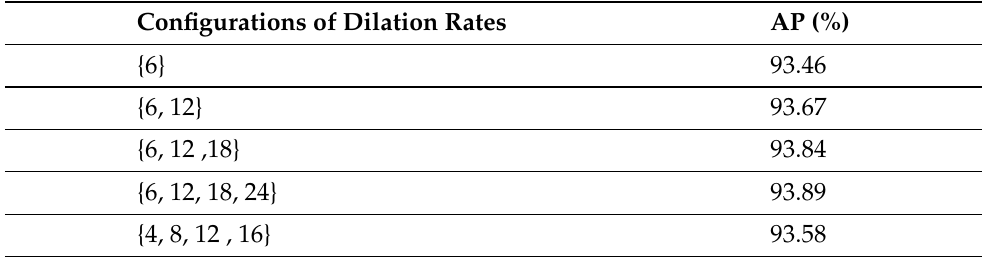
Table 3. The results of different configurations of dilation rates on the Brainwash test